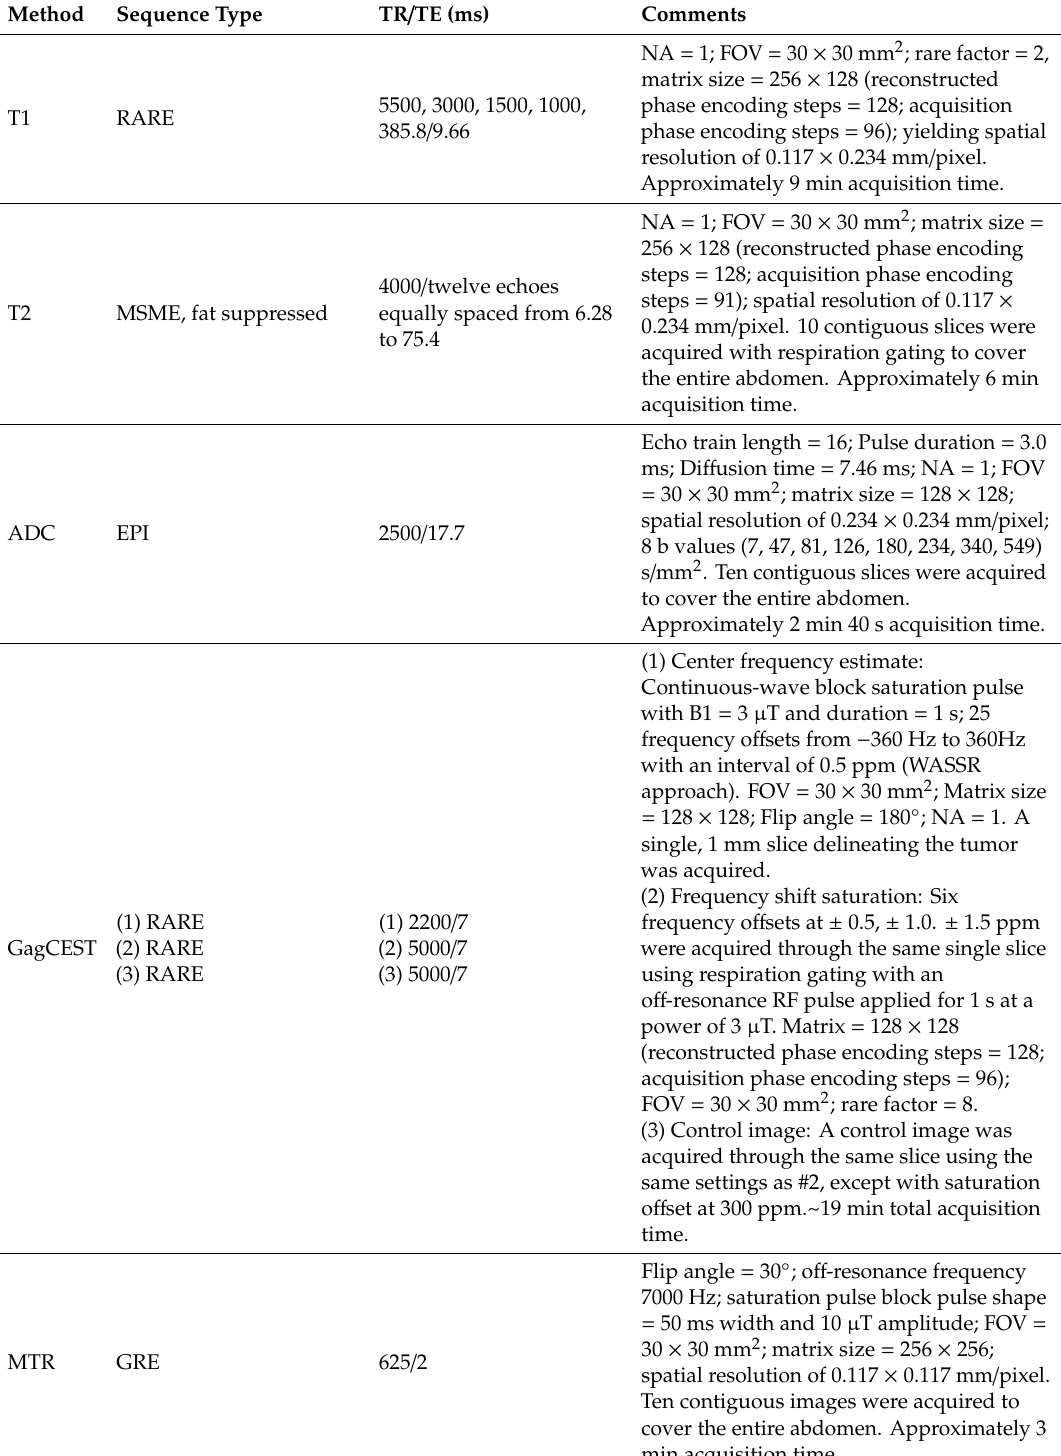
Table 1. 14T MRI parameter acquisition